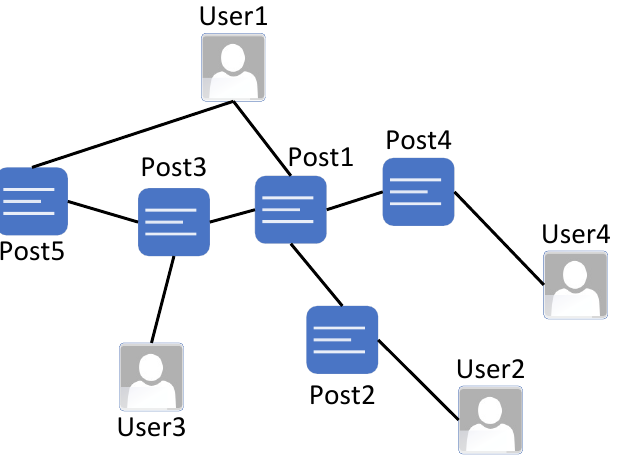
Figure 2. This is an example of the discussion network we make use of in this paper. Four users and five posts are engaged in this discussion network.